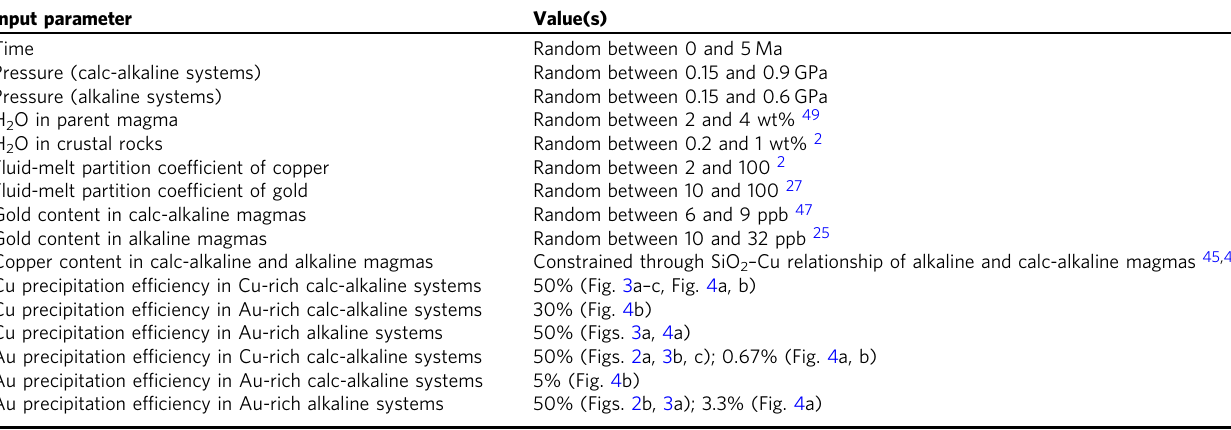
Table 1 Input parameter values used for the Monte Carlo simulations. Simulations are carried out for an injection rate of 5 mm year − 1 of a basaltic melt at 1200 °C through a disk of 7500 m radius a (equivalent to a magma fl ux of 0.0009 km 3 year − 1 ), into a crust characterised by a geothermal gradient of 20 °C km − 1 (ref. 18